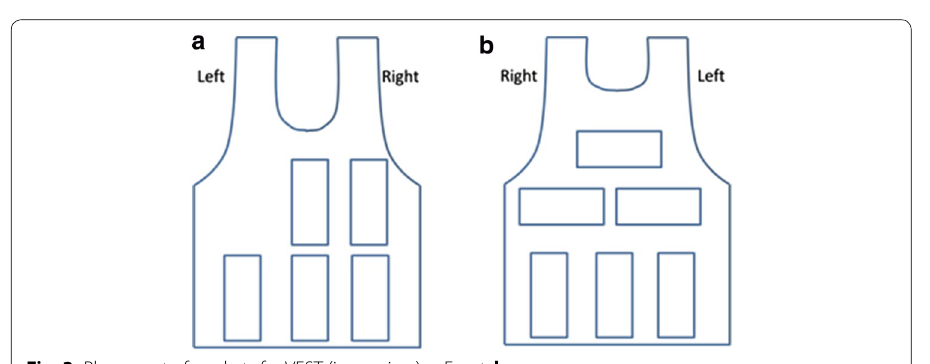
Fig. 3 Placement of pockets for VEST (inner view). a Front, b